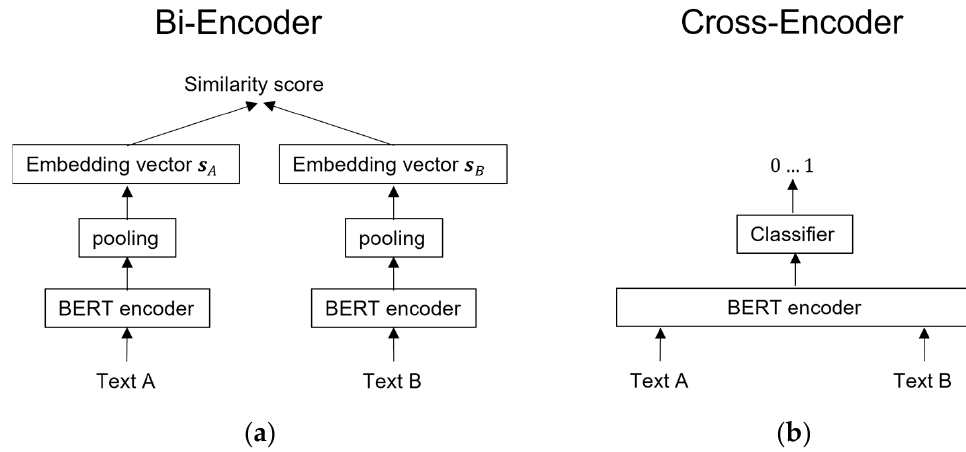
Figure 1. SBERT architectures: ( a ) the bi-encoder model and ( b ) the cross-encoder model.